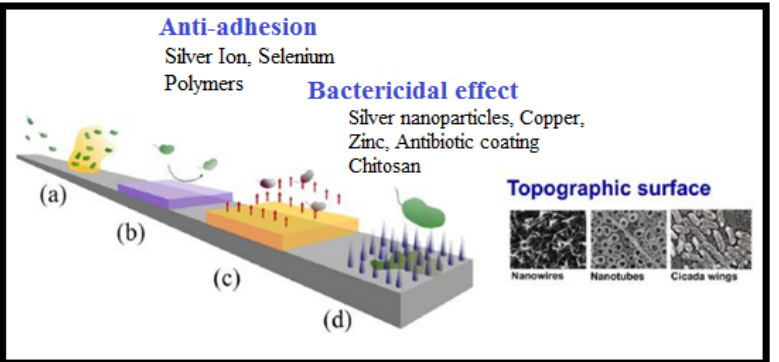
Figure 4. Common coating or printing techniques [20]. Reprinted with permission from ref. [20]. © 2021 John Wiley and Sons. © 2017 John Wiley and Sons.